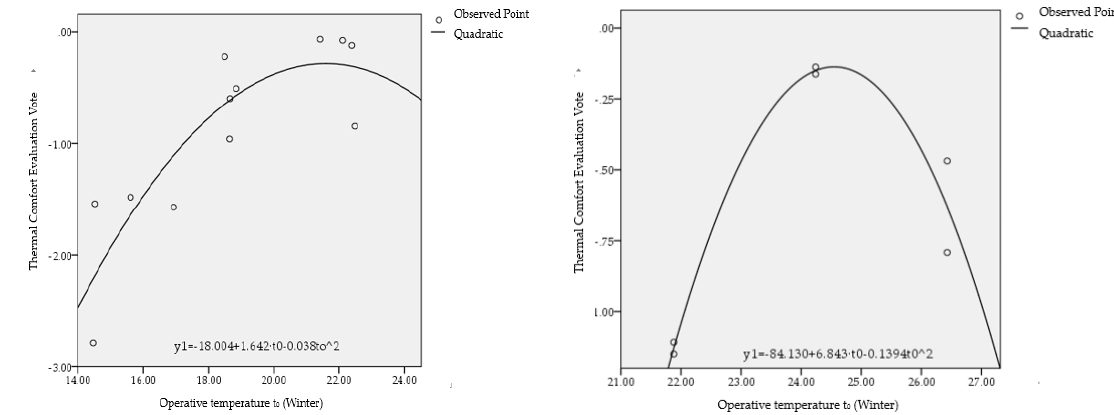
Figure 3. Thermal comfort evaluation vote.